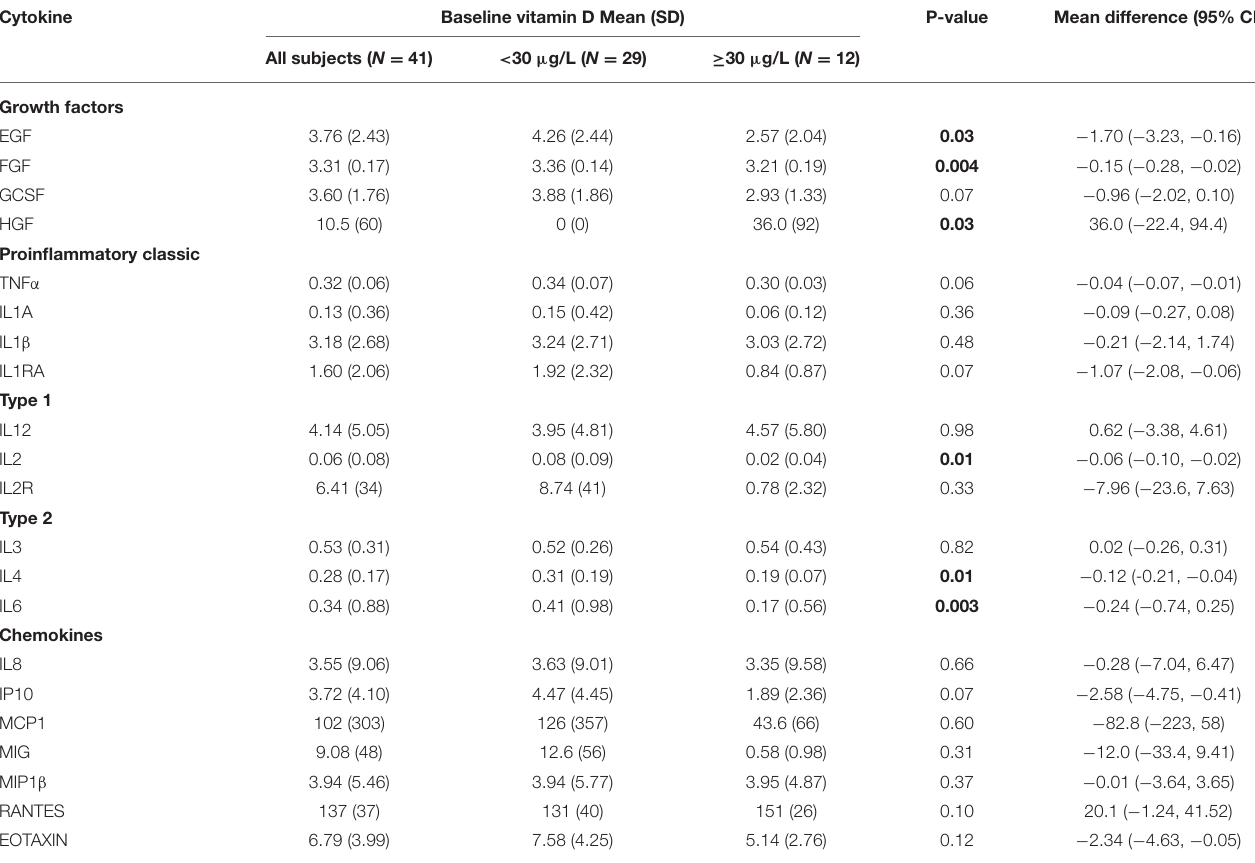
Bold values indicate the SD: standard deviation.